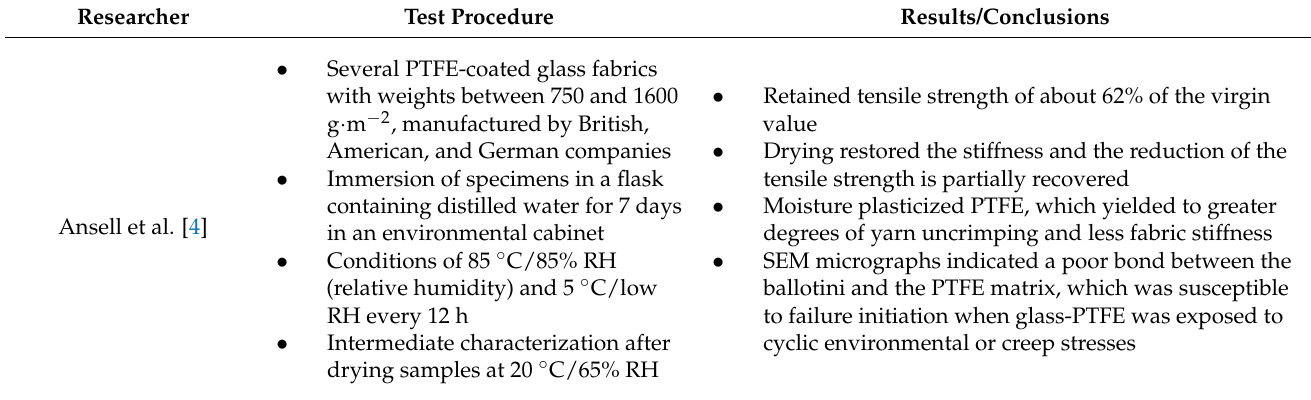
Table 2. Summary of investigations that assessed water impacts on glass-PTFE